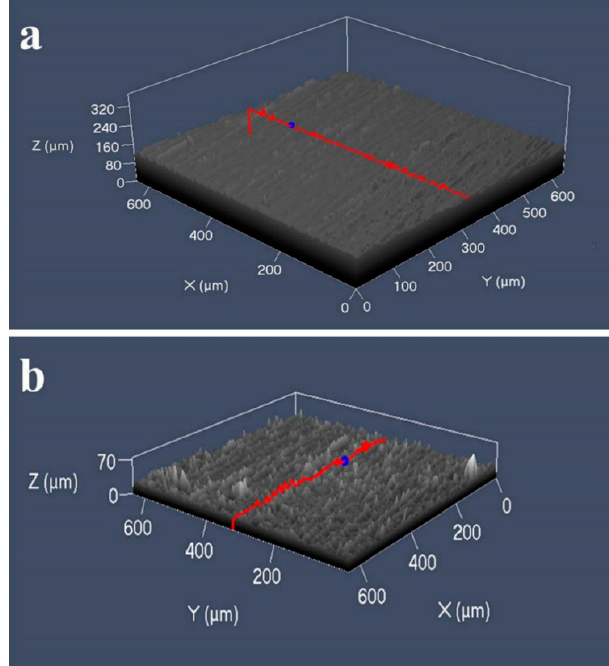
Figure 2. Surface topography of the steel plates ( a ) with and ( b ) without Bacillus sp. biofilm formation.